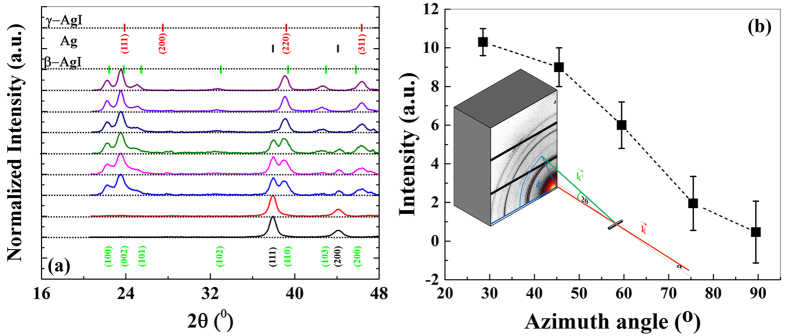
The azimuthally averaged detector GIXD patterns of the native Ag TF.(a) Azimuthally averaged GIXD patterns of the native Ag thin film and after progressive exposure to iodine. The curves are labelled by the exposure times. The tick marks indicate the Bragg angles of Ag (black), β-AgI (green) and γ-AgI (red) as indicated in SI. (b) Azimuthal distribution of the intensity scattered from (100) planes of the β-AgI crystallites after an exposure to iodine for 1800 s. The azimuth angle ϕ in this case is equal to the angle between <100> direction and the substrate. The inset visualizes the scattering geometry of the GIXD experiment with the incident x-ray beam () and the scattered beam (). In our experiment  is inclined with respect to the sample surface by 0.2°.